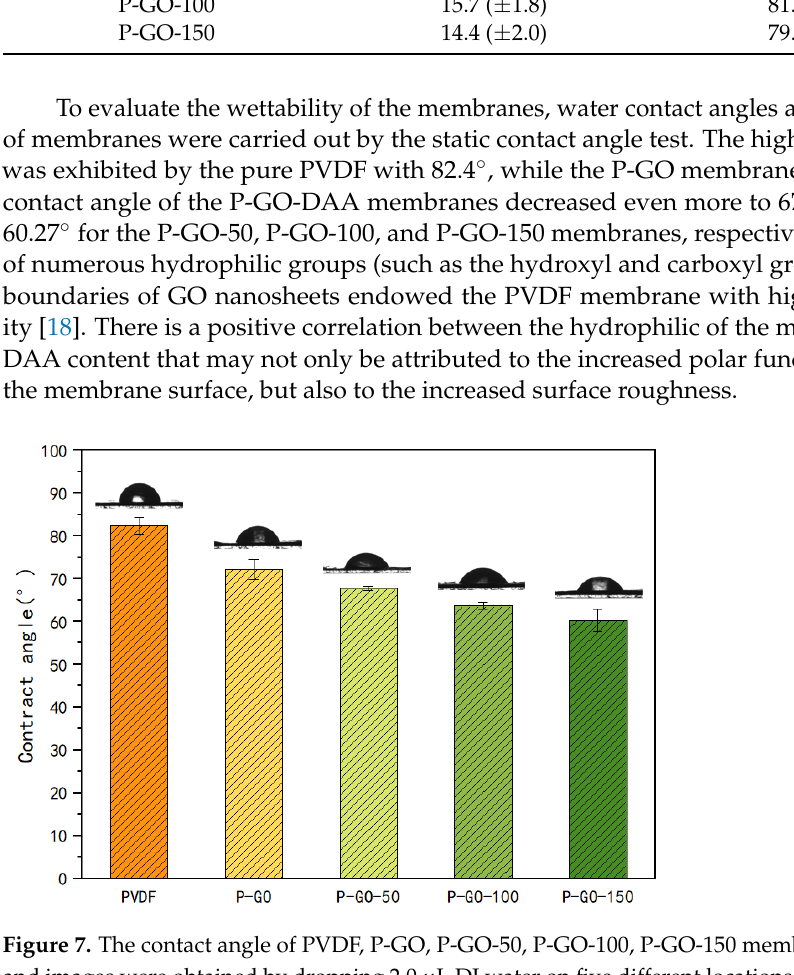
Figure 7. The contact angle of PVDF, P-GO, P-GO-50, P-GO-100, P-GO-150 membrane. The CA data and images were obtained by dropping 2.0 μ L DI water on five different locations for each mem- brane surface sample at room